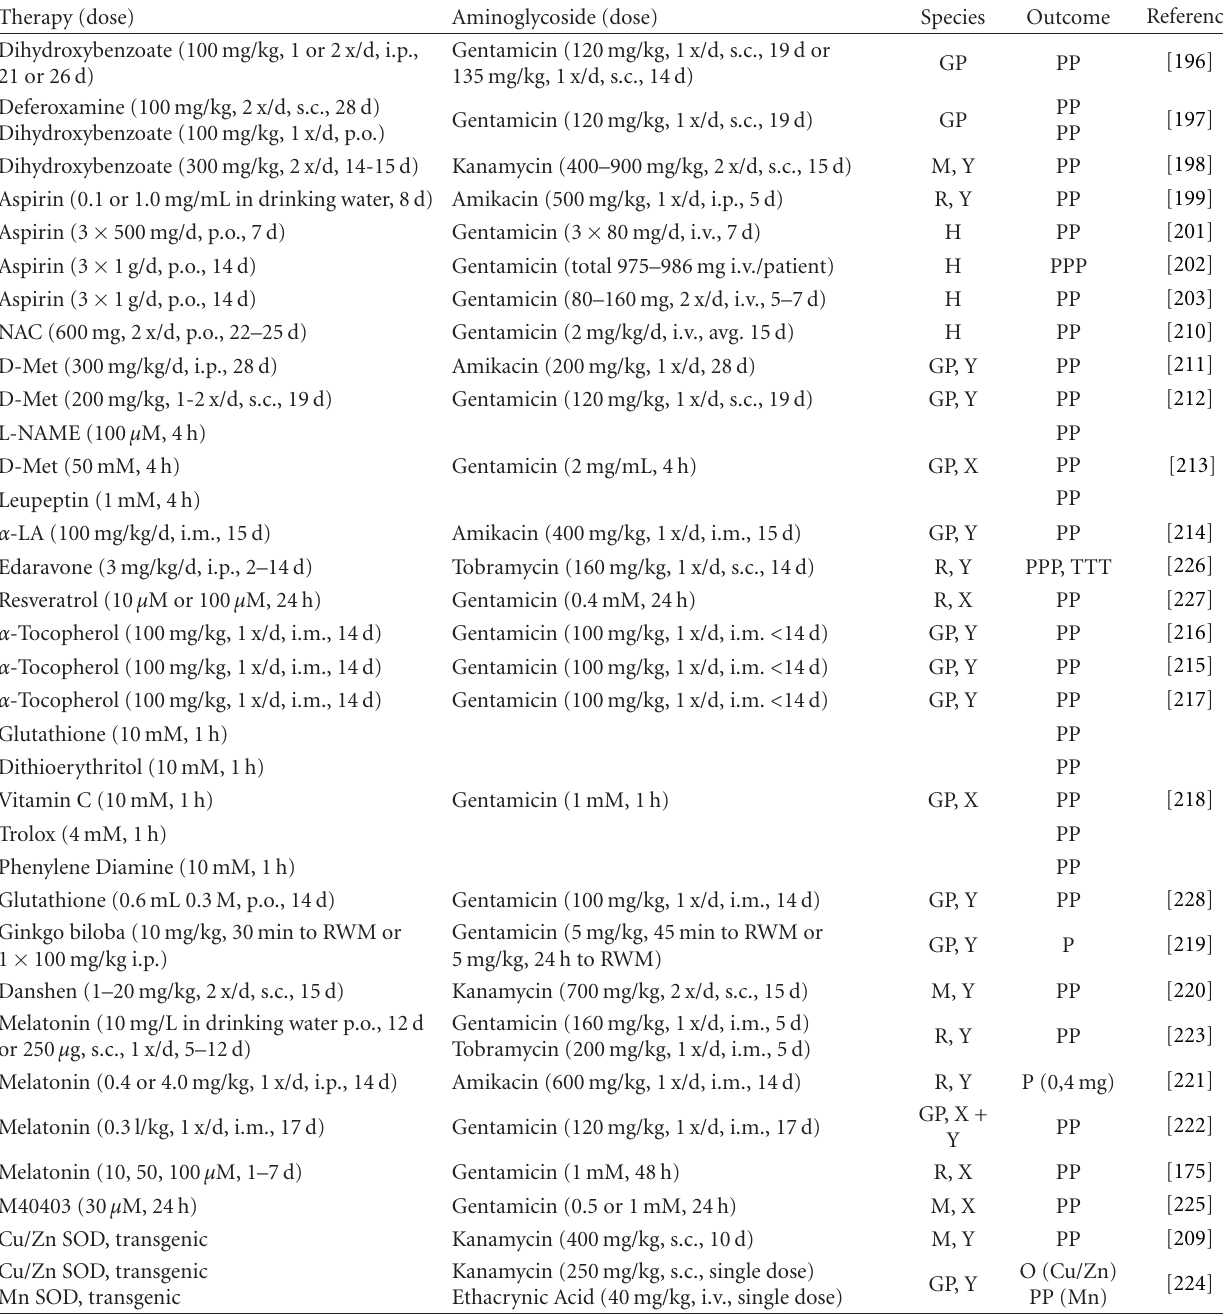
Table 2: Overview of studies performed to protect from aminoglycoside ototoxicity by antioxidants. C: Chicken, CH: Chinchilla, G: Gerbil, GP: Guinea Pig, H: Human, M: Mouse, R: Rat, ZF: Zebrafish; X: in vitro , Y: in vivo ; i.m.: intramuscular, i.v.: intravenous, i.p.: intraperitoneal, i.t.: intratympanic, s.c.: subcutaneous, RWM: round window membrane; d: day, h: hour; O: no e ff ect; P/PP/PPP: partial, not significant/partial and statistically significant/complete & statistically significant protection; T/TT/TTT: partial, not significant/partial and statistically significant/complete & statistically significant